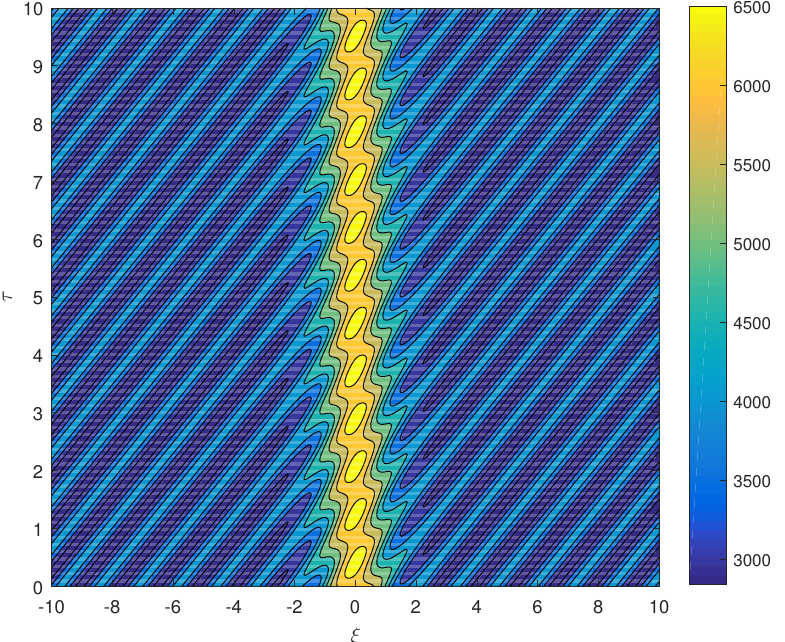
Figure 12. The contour plot of φ 1 given by (40).